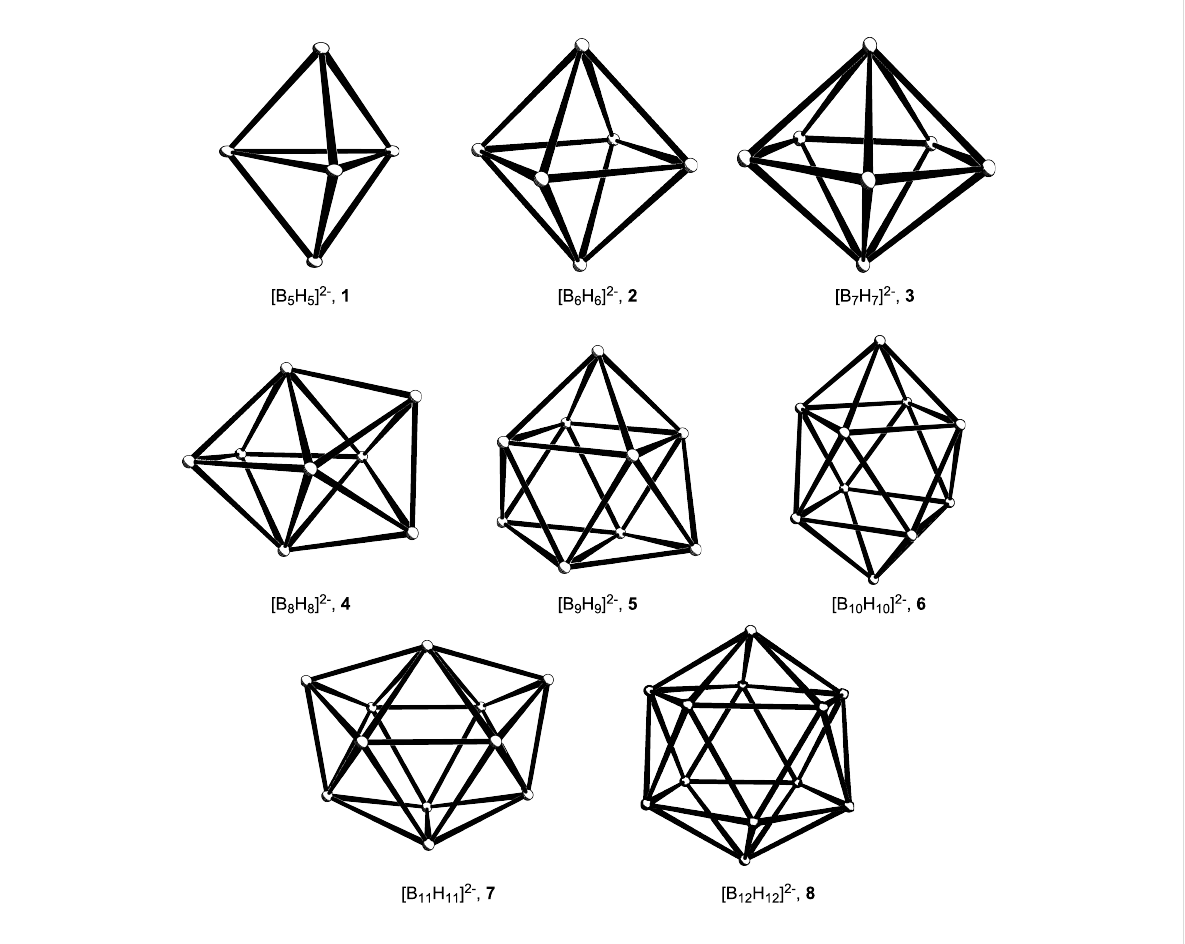
Figure 3: The deltahedra corresponding to the structures of the closo -boranes [B x H x ] 2 − .